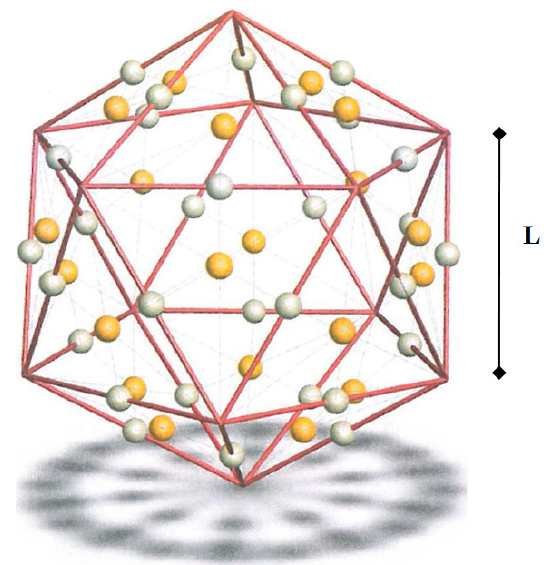
Figure 4. Third variation of the icosahedral model.